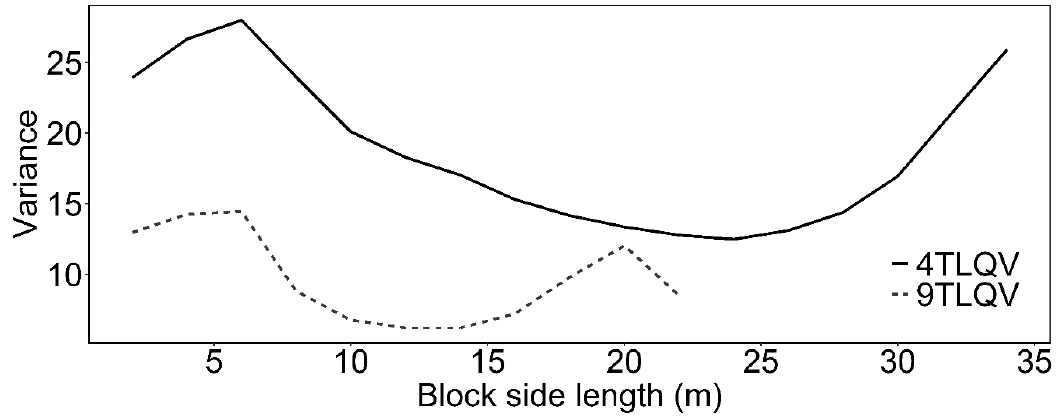
Figure 2. Variance-block length graph for the four-term local quadrat variance (4TLQV) and the nine-term local quadrat variance (9TLQV) for saplings (stems with height ≥ 1.30 m and dbh < 10 cm).